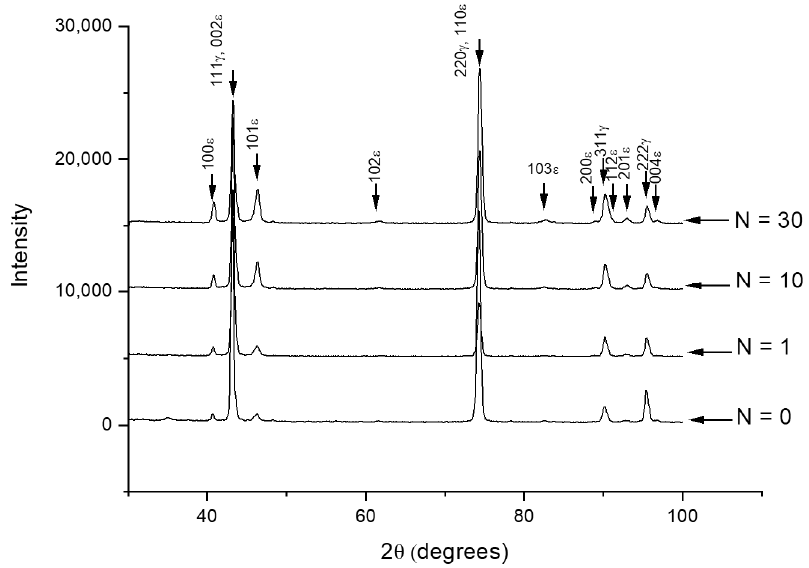
Figure 9. X-ray diffractograms Fe-30Mn-5Si alloy (HR 800 ) after various number of loading–unloading cycles ( N ) in accordance with Figure 8.